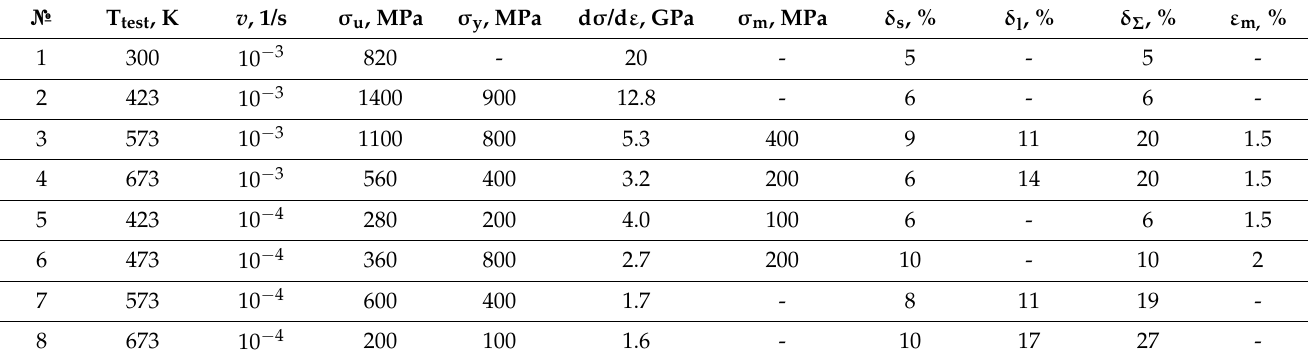
Table 7. TensiletestresultsatelevatedtemperaturesfortheUFGCu–14Al–3NialloyafterHPT to 10